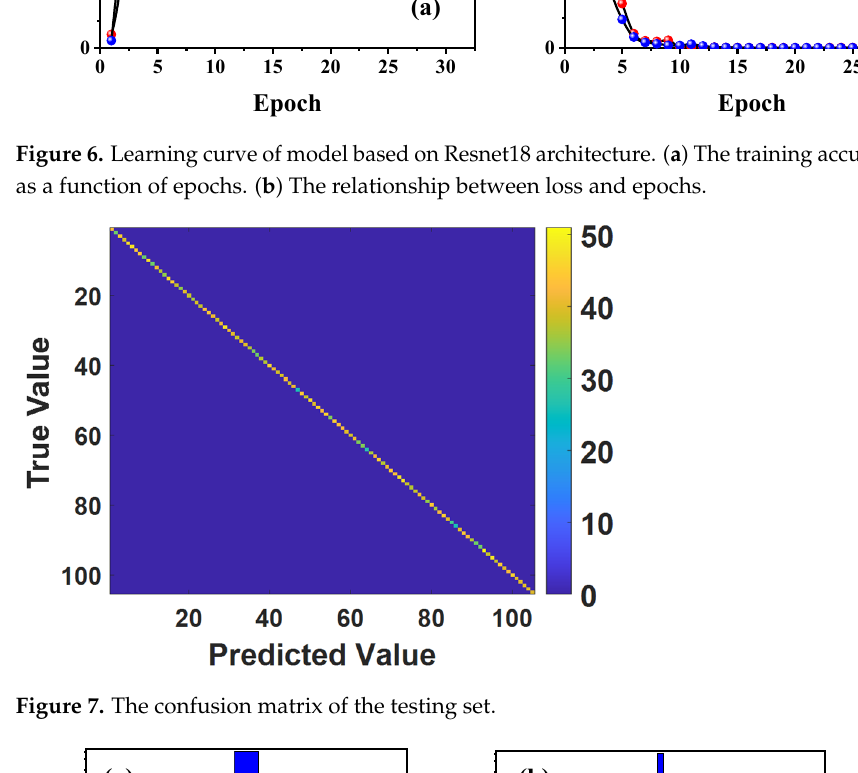
Figure 6. Learning curve of model based on Resnet18 architecture. (a) The training accuracy is plotted as a function of epochs. (b) The relationship between loss and epochs.